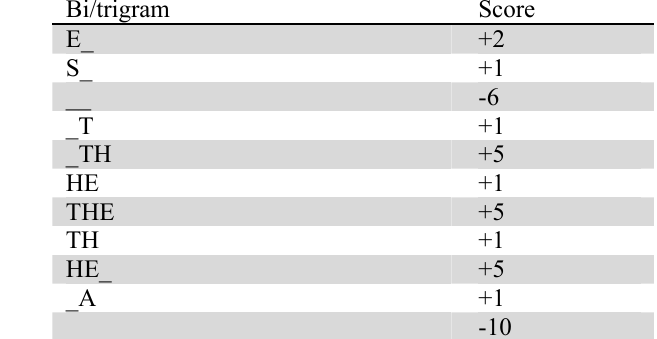
Weights proposed by Clark (1998a, 1998b) Reformed weights by Clark (1998a, 1998b) Bi/trigram Score Bi/trigram